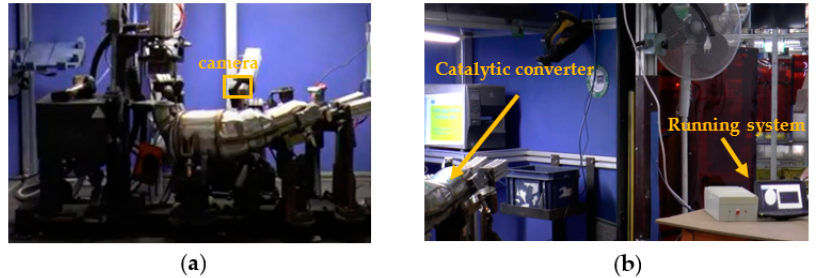
Figure 15. The time breakdown of the geometrical inspection algorithm when running on the embedded system of Figure 11.